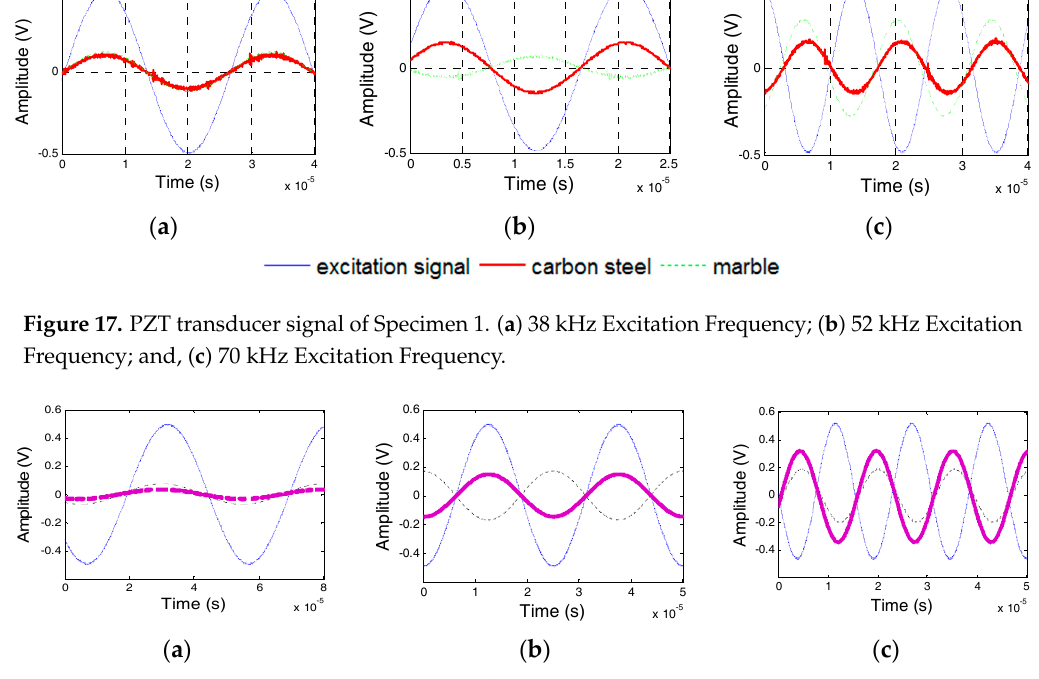
Figure 17. PZT transducer signal of Specimen 1. ( a ) 38 kHz Excitation Frequency; ( b ) 52 kHz Excitation Frequency; and, ( c ) 70 kHz Excitation Frequency.